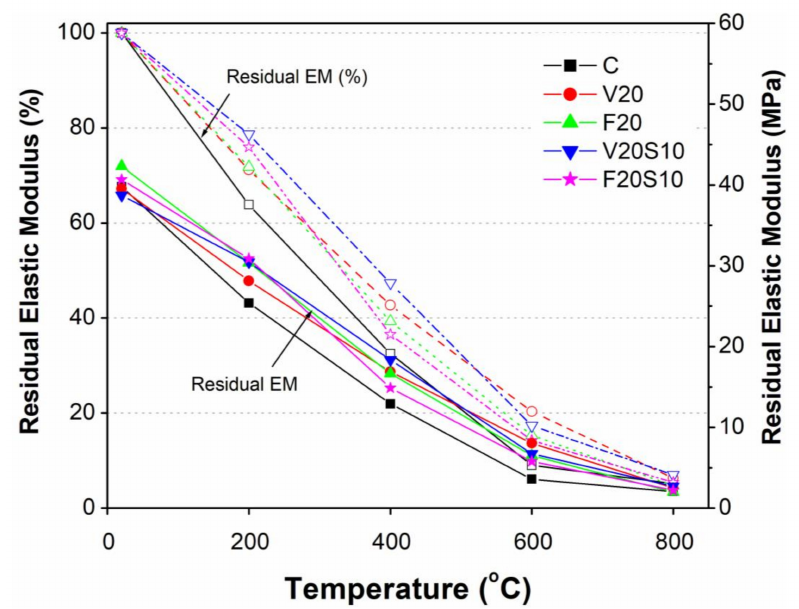
Figure 9. Comparison of residual elastic modulus of VA concretes with CC and reference FA